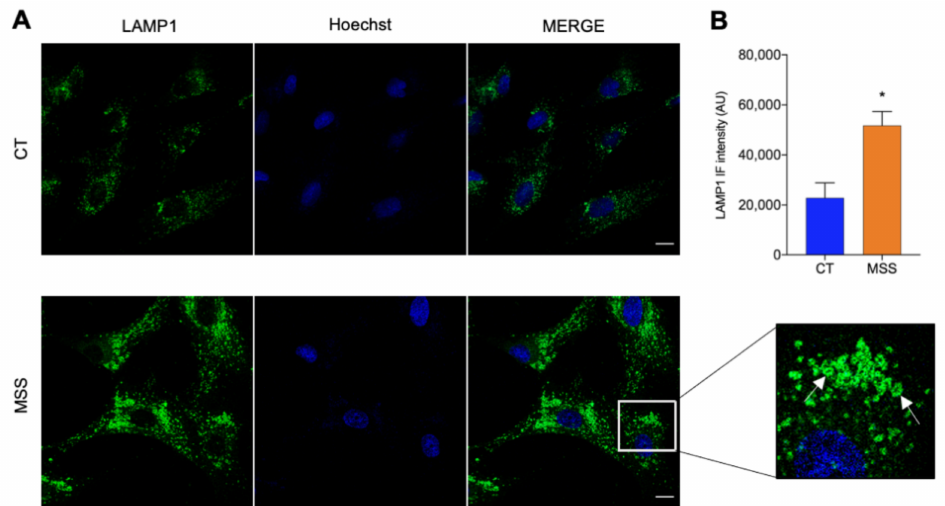
Figure 2. LAMP1-positive structures increase in HF-MSS cells. ( A ) HF-CT (CT) and HF-MSS (MSS) were plated on glass coverslips, fixed in PFA 4%, and processed for immunofluorescence. Confocal images of cells immunostained for LAMP1 (green) and reacted with Hoechst 33342 (blue) to stain the nuclei. The merge of green and blue channels is represented in the third panel. A magnification of the squared area is also shown. White arrows indicate ring-like structures. Scale bar: 20 µ m. ( B ) Quantification of total LAMP1 staining shown in A. * p <